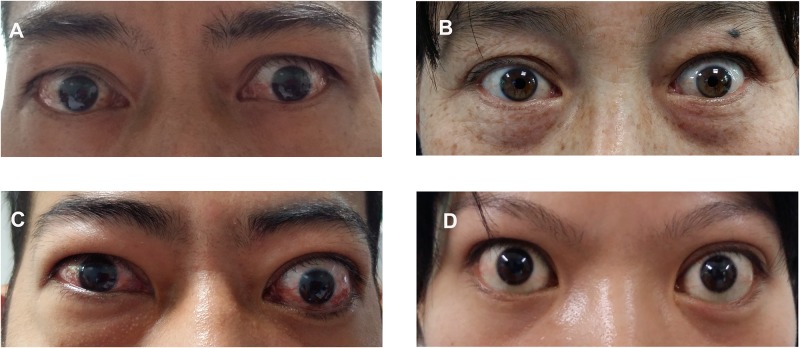
Examples of clinically active and inactive TAO.(A) Moderate active TAO with lid retraction, inflammation of orbital soft tissue for both eyes. (B) Moderate inactive TAO with lid retraction. (C) Severe active TAO with severe binocular soft tissue inflammation, upper eyelid retraction and 25mm of Hertel reading for left eye. (D) Severe inactive TAO with lid retraction and 23mm of exophthalmos.